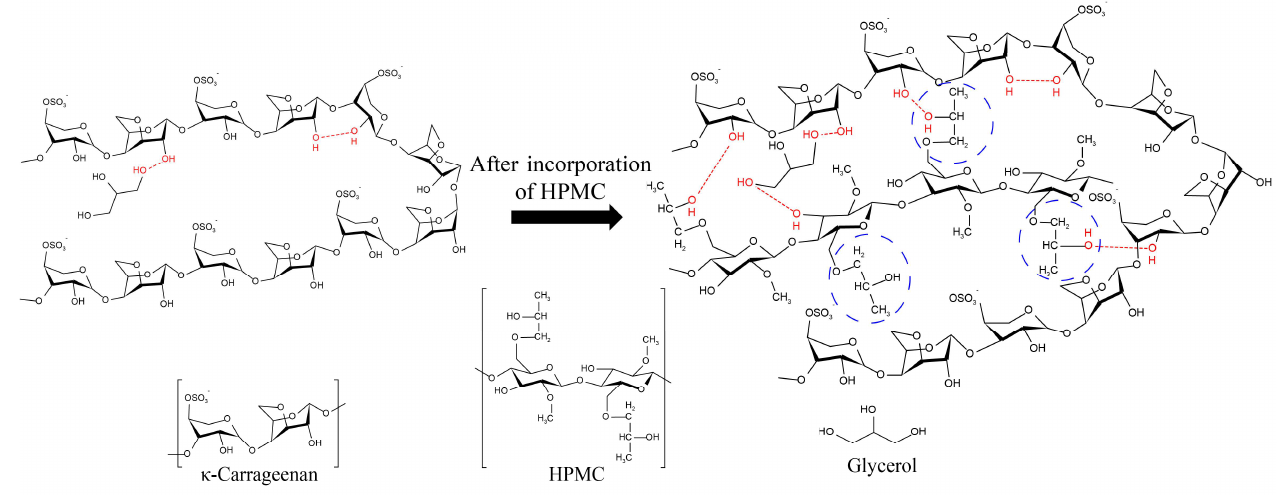
Figure 2. Schematic of possible intermolecular interactions in κCHM films.